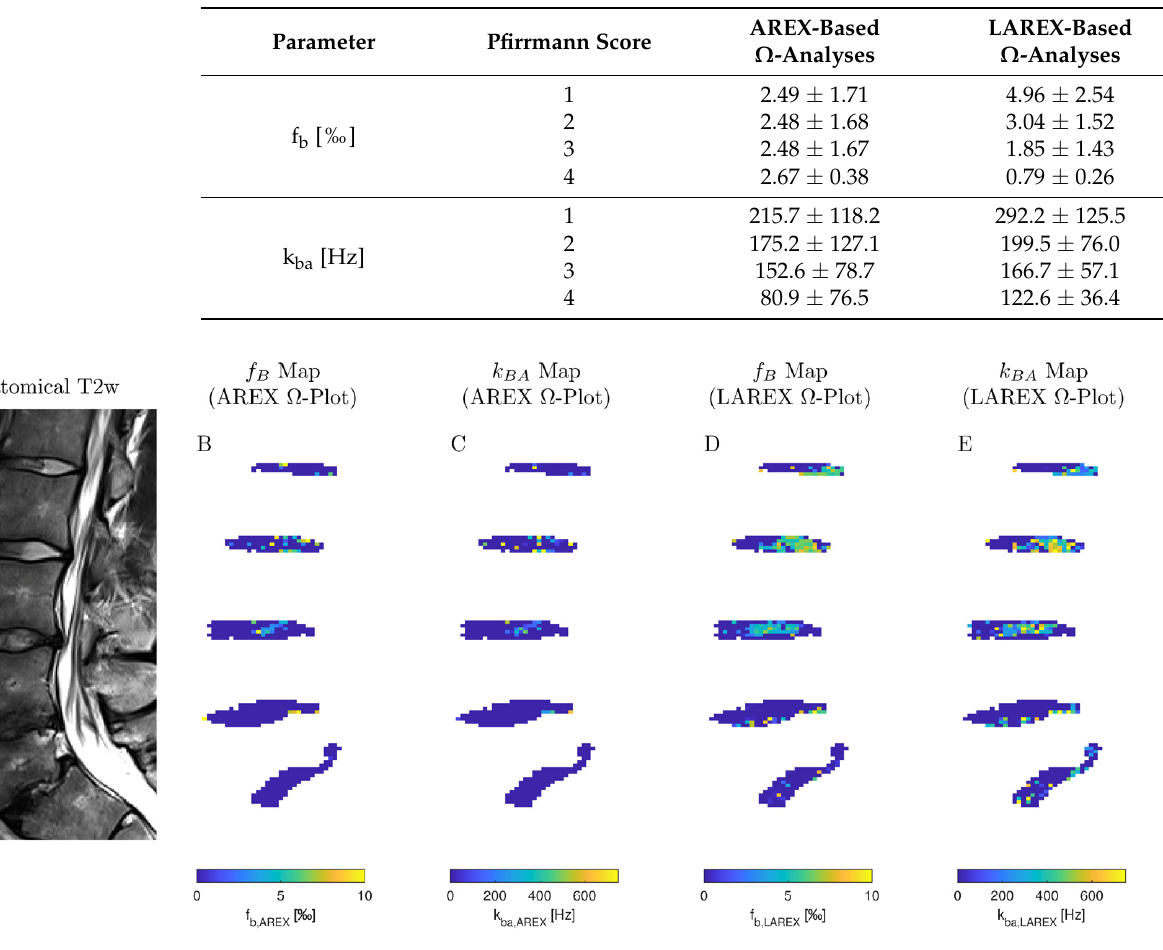
Figure 4. A sagittal image of representative IVDs and the corresponding exchange rate maps in one subject. ( A ) T2-weighted image in the sagittal plane (Pfirrmann scores from head to feet: 2, 2, 3, 4, and 4). ( B , C ) Exchange rate maps of the corresponding IVDs using the AREX method. ( D , E )